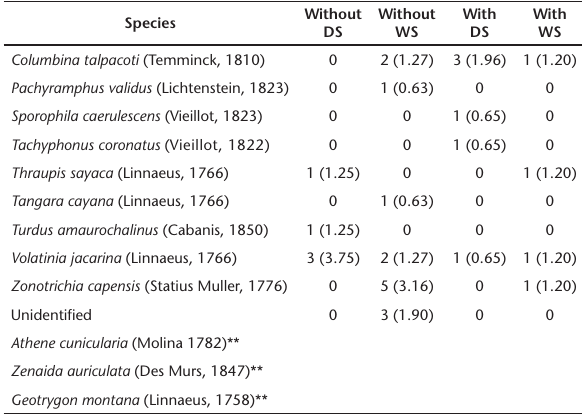
Table 1. Bird-window collisions for two buildings (ATLAB and GAD) on the campus of the Federal University of São Carlos, Sorocaba, Brazil, during the wet (October to March) and dry (April to Septem- ber) seasons, in windows without and with bird-of-prey decals. DS = dry season; WS = wet season. In parentheses, values expressed as (number of fatalities/day) x100*.